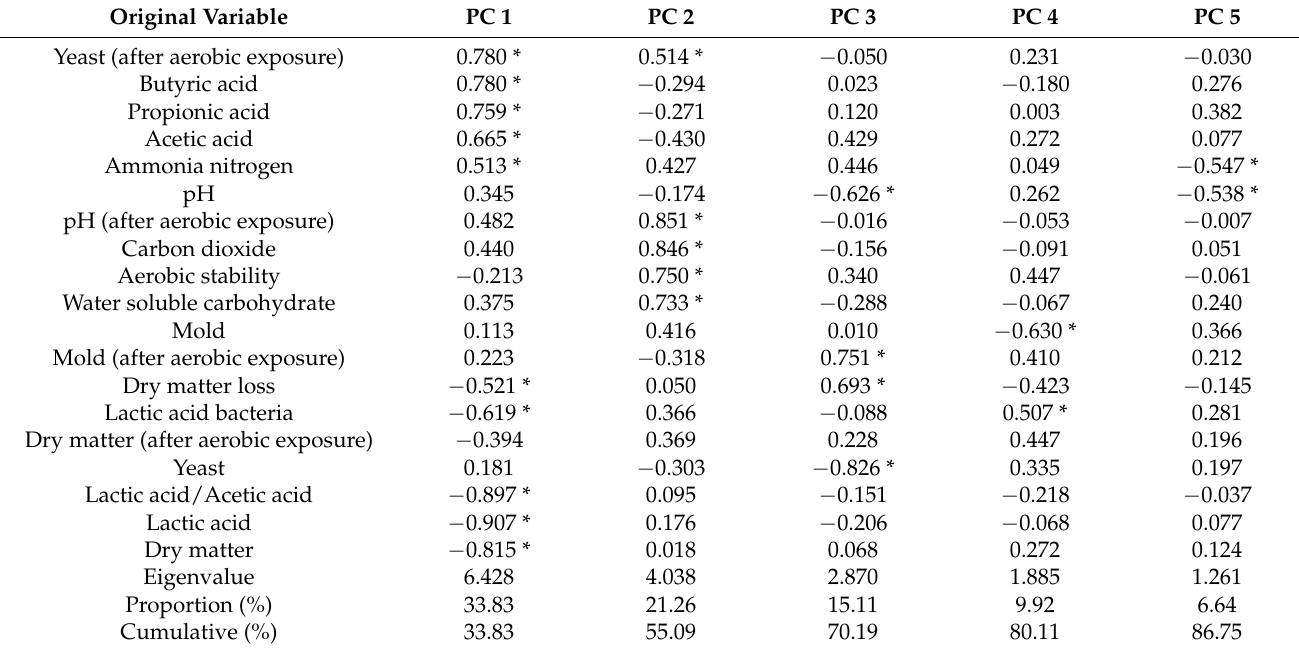
Table 2. Loading vectors of original variables after 45 d of ensiling alfalfa treated with different kefir source 1